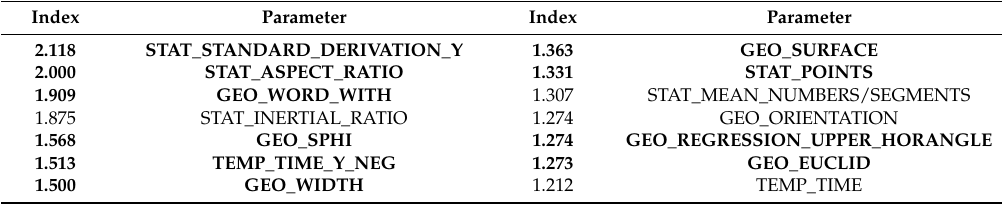
Table 8. Ranked Result for Info Gain Attribute Select on Secure Password DB